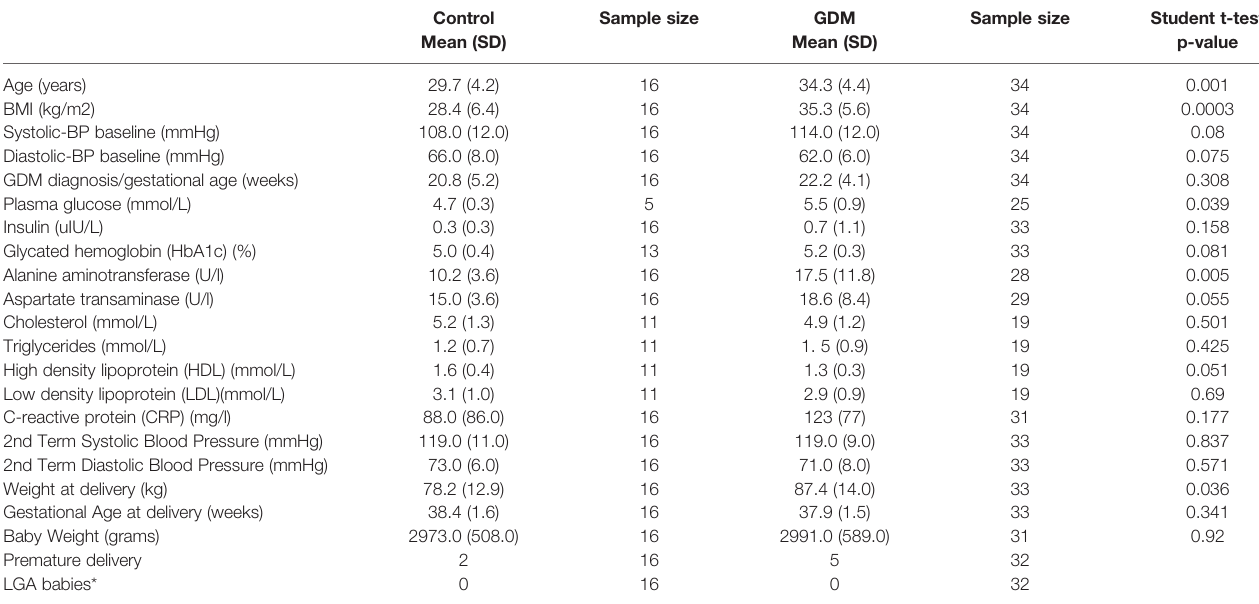
TABLE 1 | Demographic and biochemical data of the gestational diabetes (GDM) and control women.